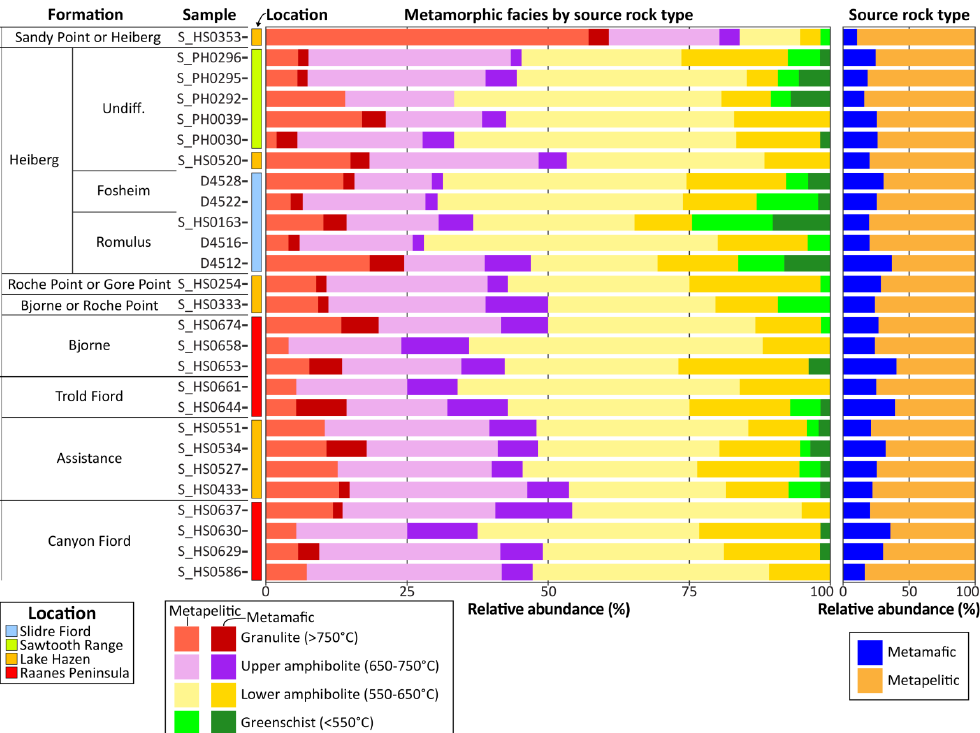
Figure 8. Bar chart summarising the likely source rocks and metamorphic grade from which the rutile grains were derived. Grains were classified into metapelite and metamafic types based on Cr and Nb concentrations following Meinhold et al. [93]. Temperatures were estimated using the Zr-in-rutile thermometer [94] and grouped into metamorphic facies. Undiff. = undifferentiated.